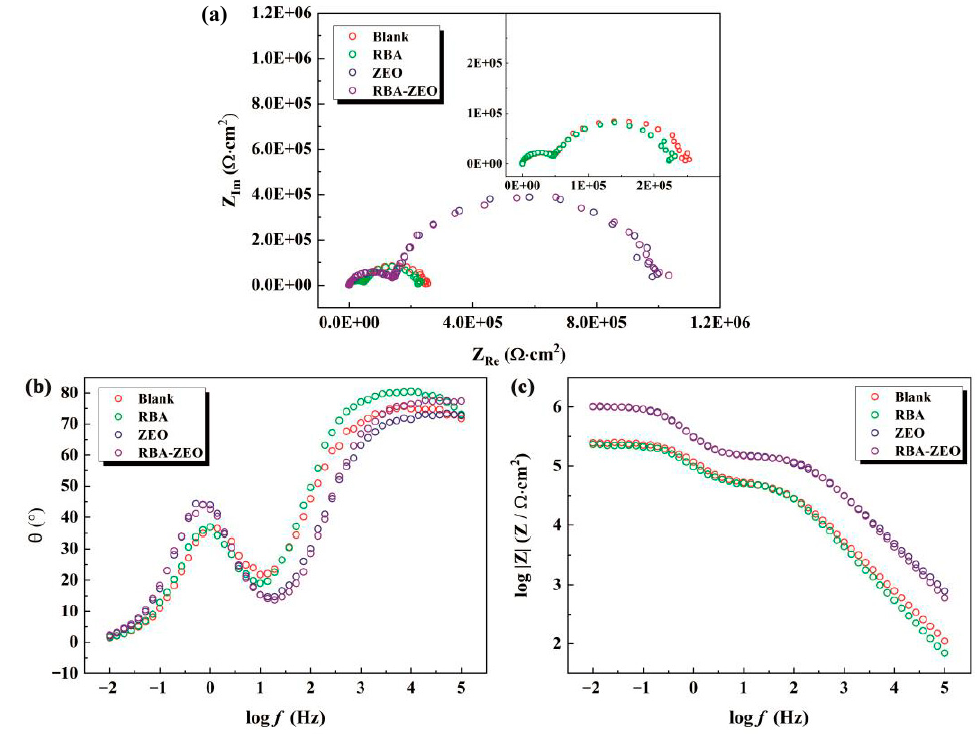
Figure 4. Electrochemical impedance spectroscopy of four epoxy coatings, ( a ) Nyquist, ( b ) Bode-phase angle and ( c ) Bode-|Z|.